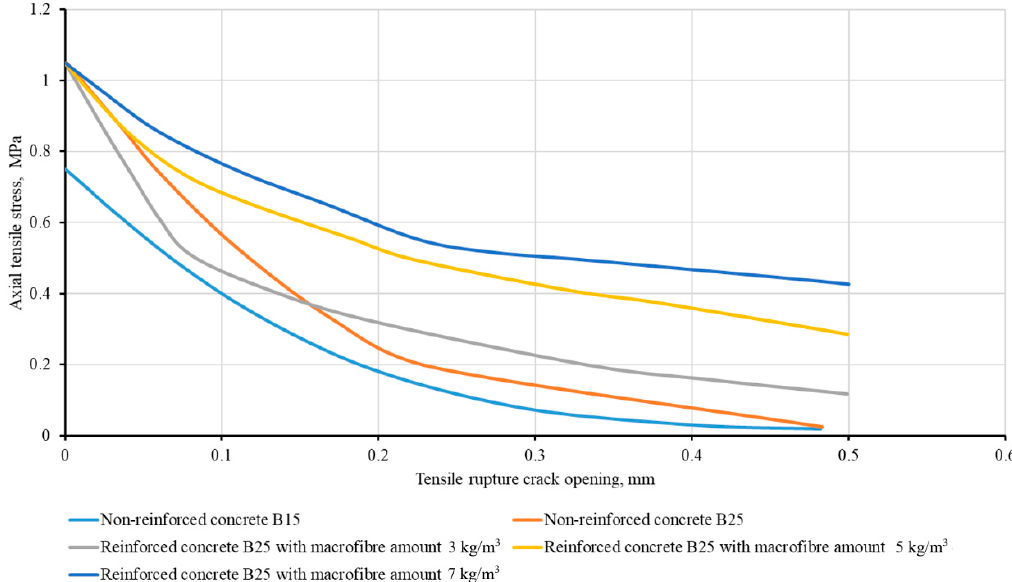
Figure 10. Uniaxial tensile stress versus tensile rupture crack opening according to concrete specimen fracturing simulation.